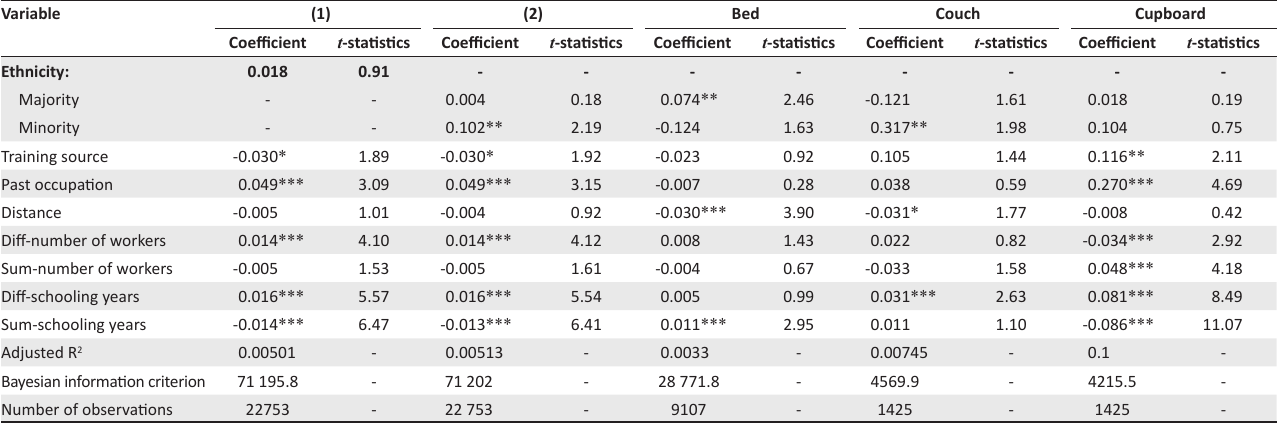
TABLE 4: Desiccation skill and ethnicity.